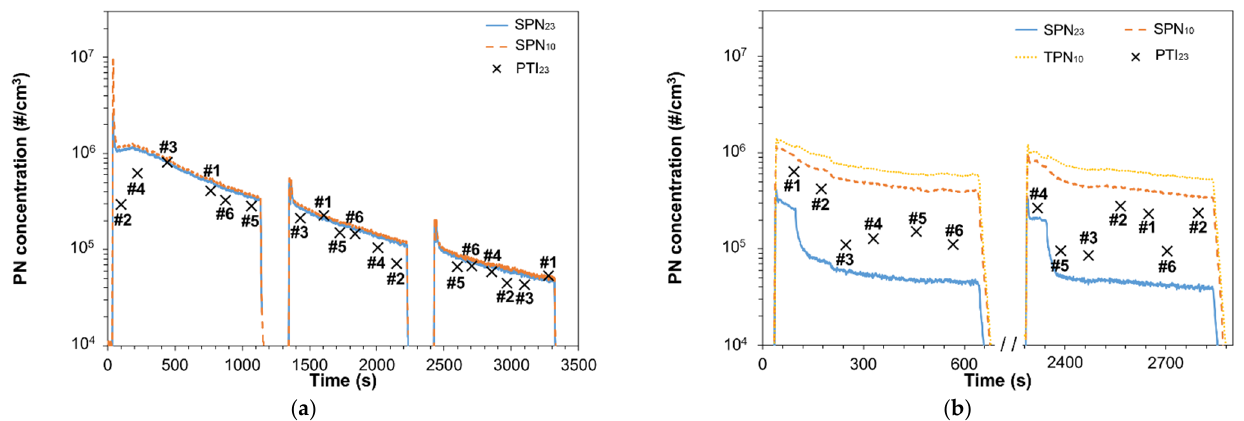
Figure 4. Particle number concentration during low idling: ( a ) After regeneration: V2 cold start and two hot starts. Hot engine ignitions were done few minutes after switching off the engine; ( b ) High sub-23 nm fraction: V1 cold start and one hot start.